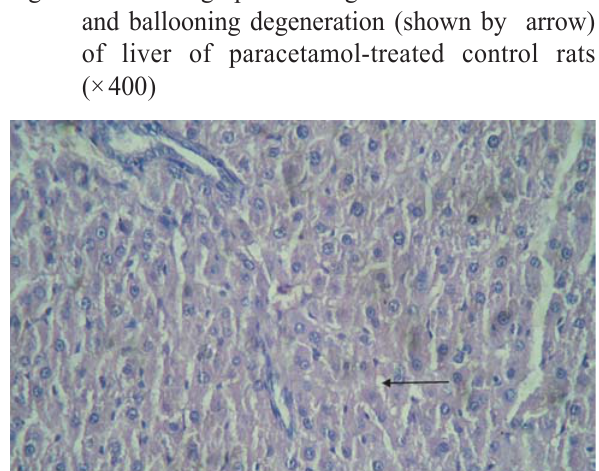
Fig 3. Photomicrograph showing centrilobular necrosis and fatty changes (shown by arrow) of liver of paracetamol-treated control rats (×